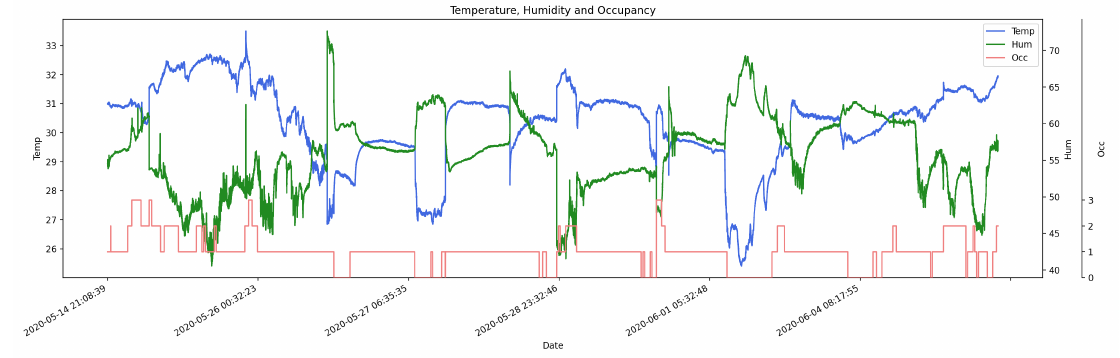
Figure 5. Humidity (green), temperature (blue), and occupancy (red) timeline of the living room data. Time gaps are not shown and occupancy is encoded from zero (Empty) to three